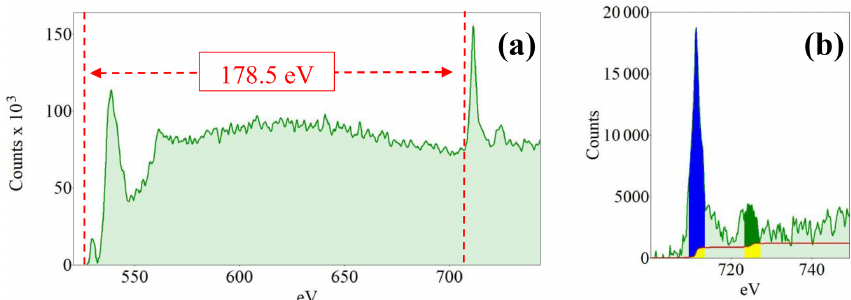
Figure 14. (a) Example of a core-loss spectrum showing both the O– K edge and Fe– L 2 , 3 edges. (b) Zoom on the Fe– L 2 , 3 edges used for the determination of the white-line intensity ratios. It displays the pre-edge background-subtracted core-loss region of a characteristic EELS spectrum with a focus on the Fe edges. The green area represents the collected original spectrum; the red line represents the double arctangent step function used to subtract the underlying background. The 4eV wide integration windows are shown in blue on the L 3 edge and in dark green for the L 2 edge. The yellow region represents the area of the window that is subtracted by the double arctangent step function.